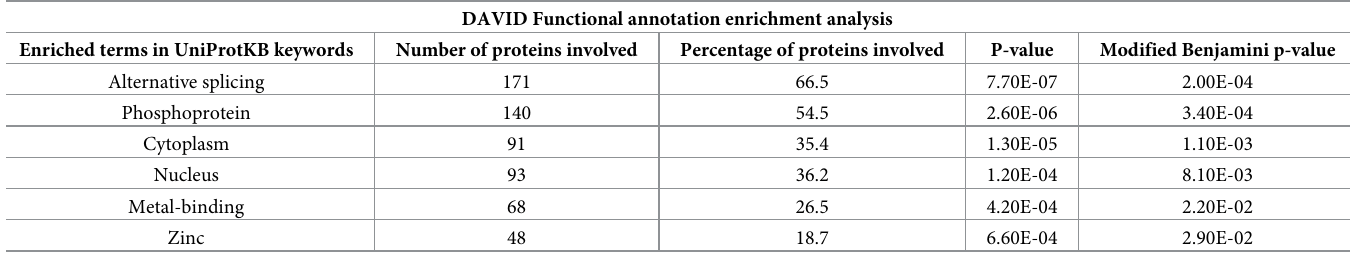
Table 4. Functional annotation enrichment for undruggable human disease associated proteins selected by PortalCG. DAVID Functional annotation enrichment